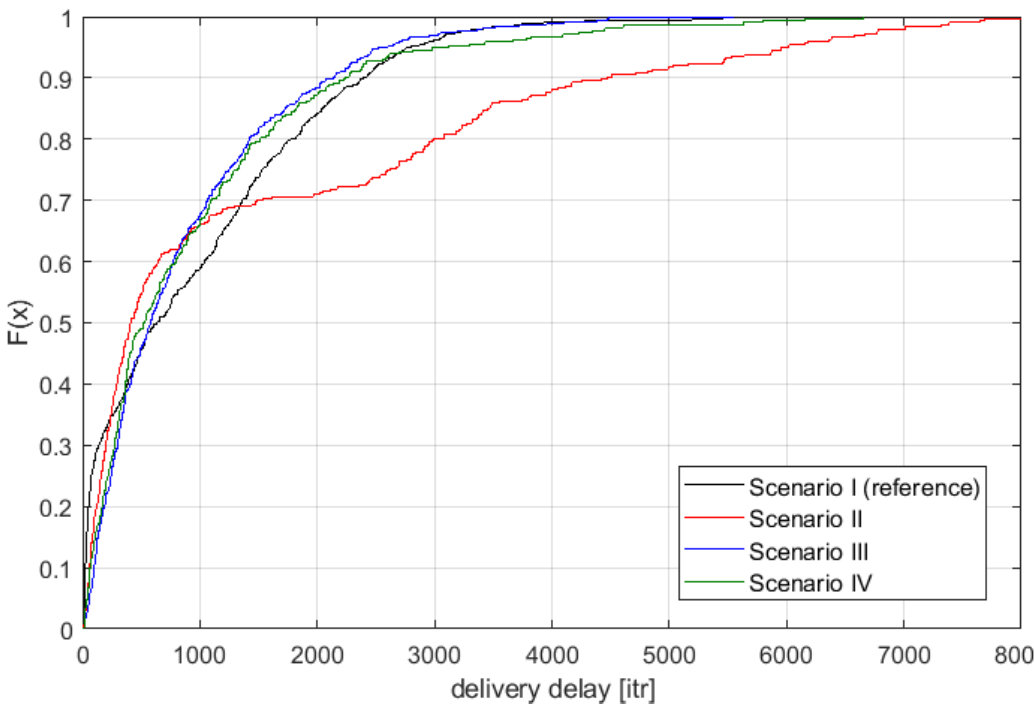
Figure 7. Distribution of delivery confirmation delay.